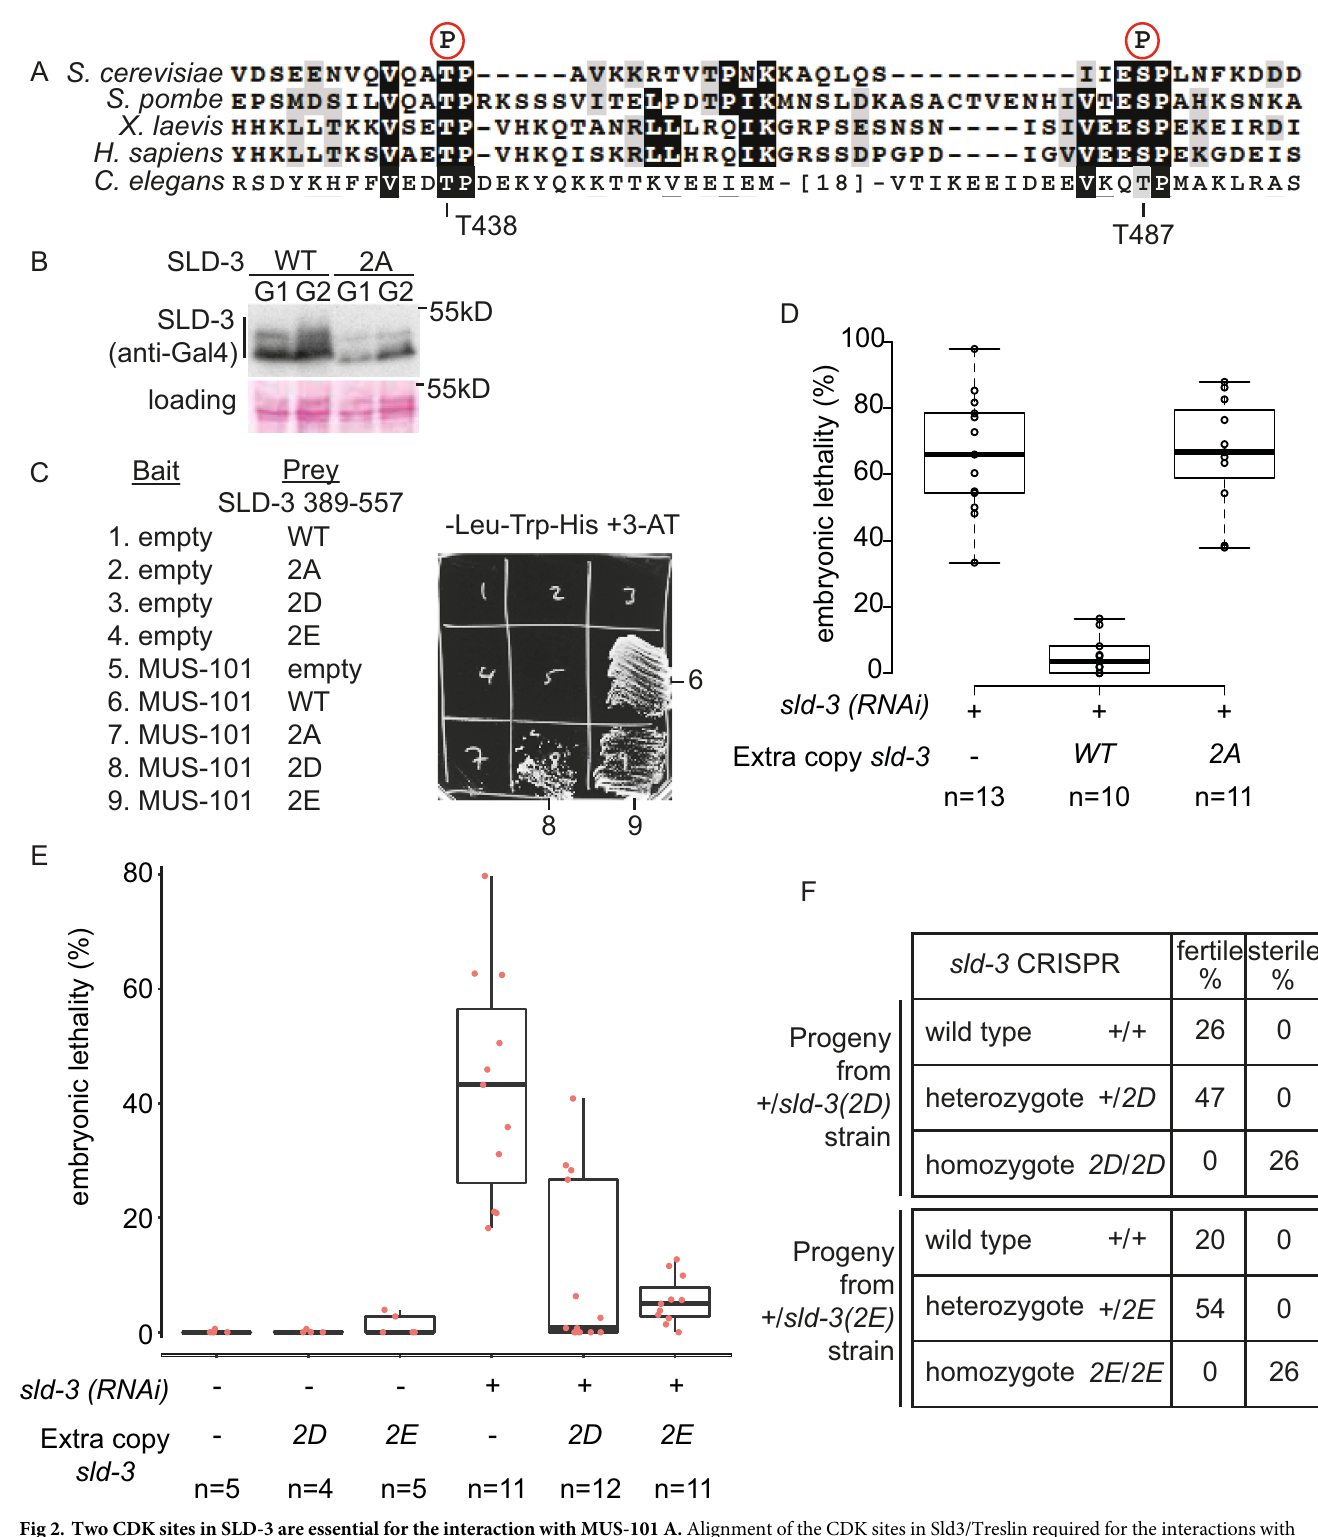
PLOS Genetics | https://doi.org/10.1371/journal.pgen.1008948 December 15,